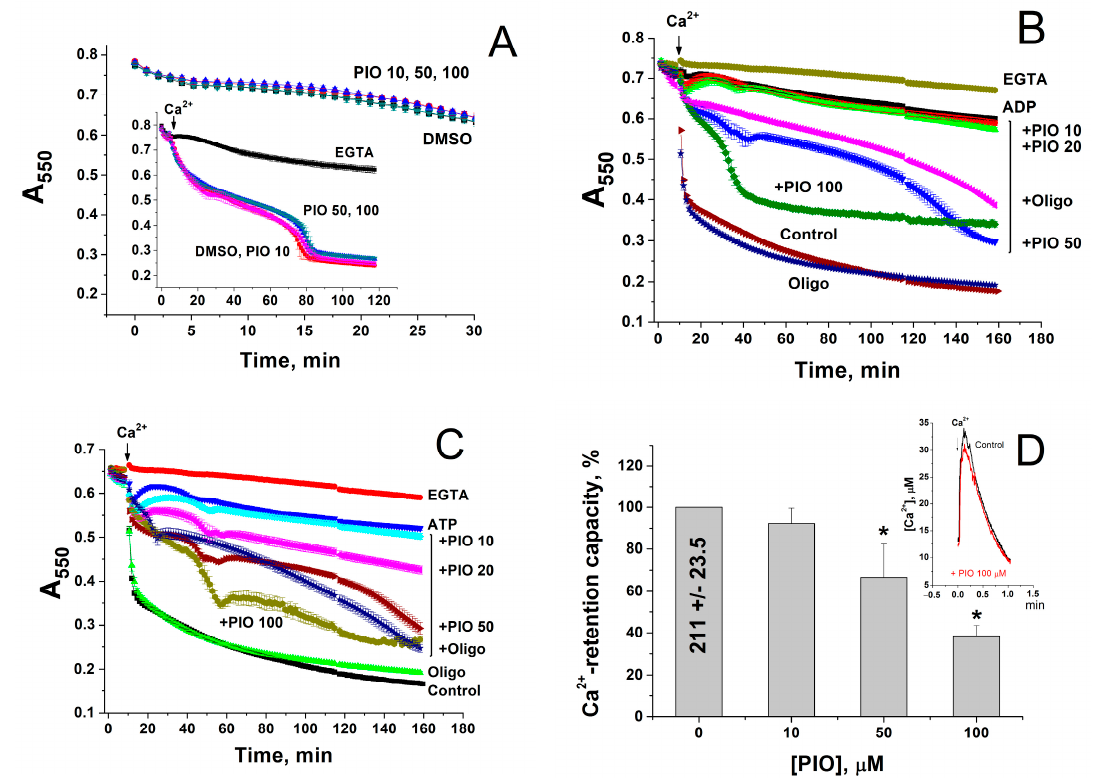
Figure 2. PIO increases mitochondrial sensitivity to Ca 2+ and decreases the protective effect of mPTP inhibitors, ATP and ADP. ( A – C ) Ca 2+ -dependent mitochondrial swelling in the presence of PIO and ATP/ADP. ( D ) Effect of PIO on